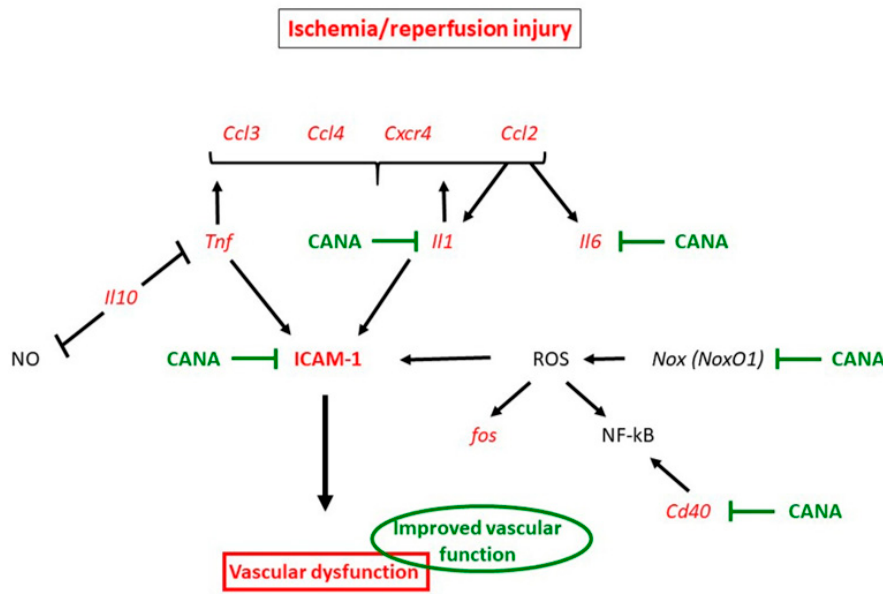
Figure 6. Simplified diagram illustrating the protective effect of canagliflozin (CANA) after vascular ischemia/reperfusion injury (IRI). IRI significantly increased the mRNA expression of Tnf and Il1 , which may increase the expression of Ccl3 , Ccl4 , Cxcr4 , Ccl2 , and ICAM-1. Additionally, IRI increased fos and Ccl2 expression and may upregulate Il1 and Il6 , all leading to vascular dysfunction. CANA reduced ICAM-1 expression possibly via preventing the upregulation of the key proinflammatory mediators Il1 , Il6 , and Cd40 and by down-regulating NoxO1, thereby alleviating endothelial dysfunction. Effects of IRI are indicated by red colors and CANA is indicated by green colors. See Table 1 for gene abbreviations.